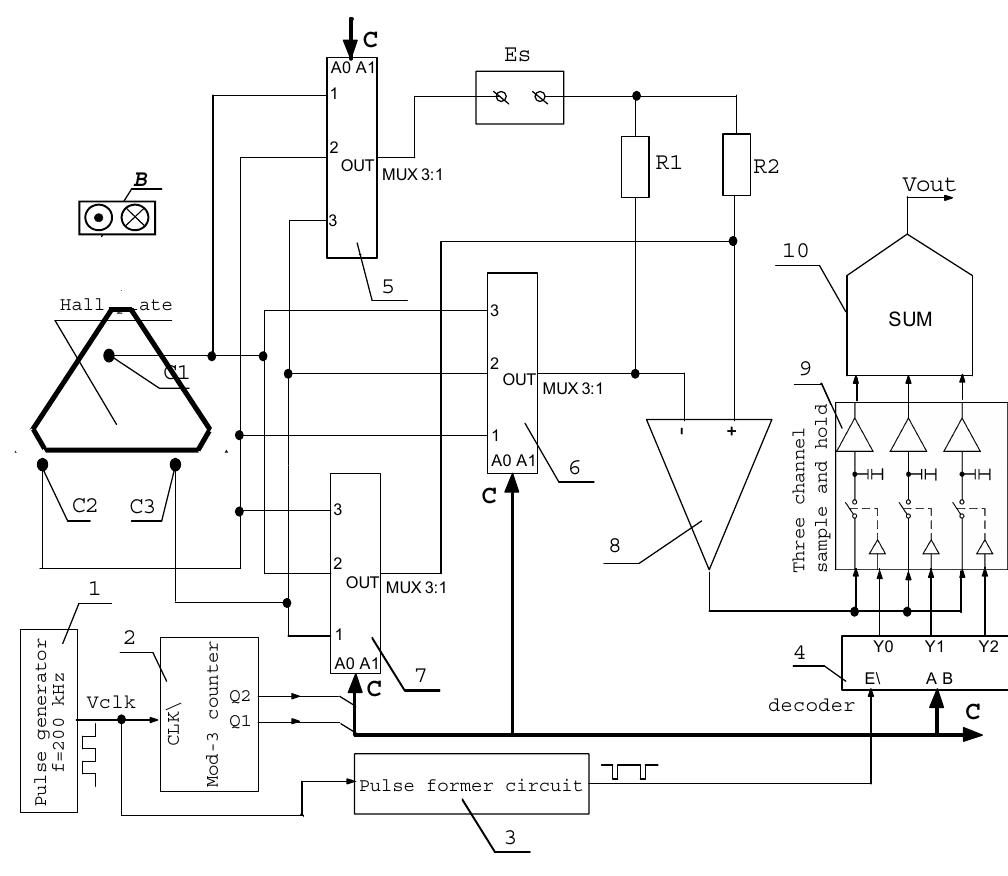
Figure 1. Block diagram of the magnetometer based on an equilateral triangular Hall